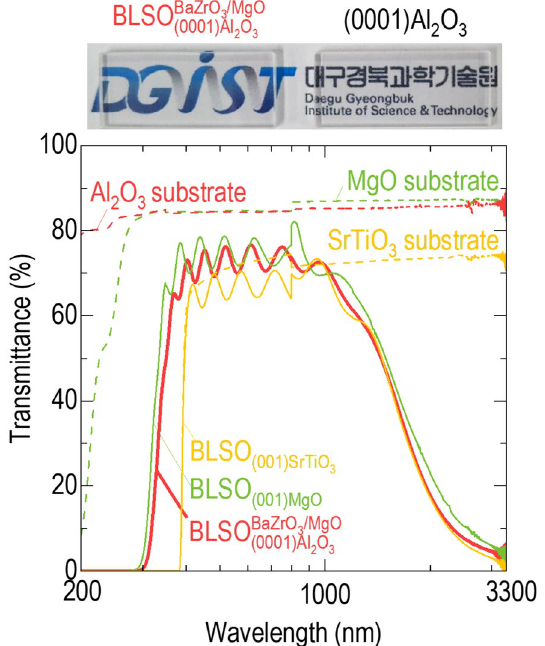
Fig. 4 Transmittance of BLSO BaZrO 3 / MgO ( 0001 ) Al . The optical images on top of 2 O 3 figure show that we can see a “DGIST” logo over film and bare Al 2 O 3 substrate, indicating that the transparency of our BLSO BaZrO 3 / MgO ( 0001 ) Al 2 O 3 films is as high as that of the substrate. All BLSO epitaxial films show high transmittances (> 75%) in the visible region and suppressed transmittances in the infrared region. The fundamental absorption edges of BLSO BaZrO 3 / MgO ( 0001 ) Al and BLSO ( 001 ) MgO , at which the 2 O 3 transmittance drops sharply at ultraviolet wavelengths, are located at shorter wavelengths than that of BLSO ( 001 ) SrTiO . The dashed lines 3 indicate the transmittances of Al 2 O 3 , MgO, and SrTiO 3